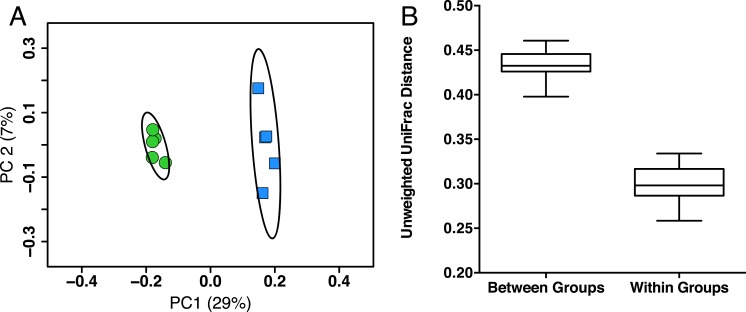
Young and aged mice are distinctive at the beta-diversity level using UniFrac metric.(A) Principal coordinates analysis using unweighted UniFrac distance on 16S sequences from fecal microbiota of young (2 months, blue) and aged (26 months, green) mice showing there are distinct phylogenetic differences in the gut microbiome between young and aged mice. Ellipses represent 95% confidence intervals. (B) Within-age-group beta-diversity is significantly lower than the between-age-group diversity, indicating that the composition of gut microbiomes from aged mice significantly differs from those of young mice (taxon abundance weighted and unweighted UniFrac; p < 0.01, Bonferroni corrected non-parametric t-tests’).